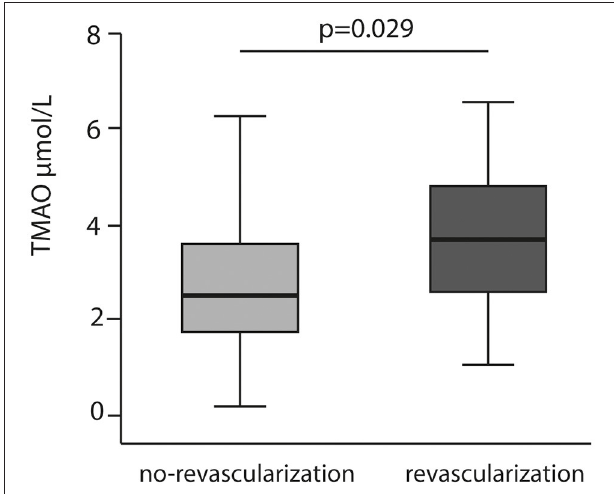
FIGURE 1 | TMAO levels relation to repeated